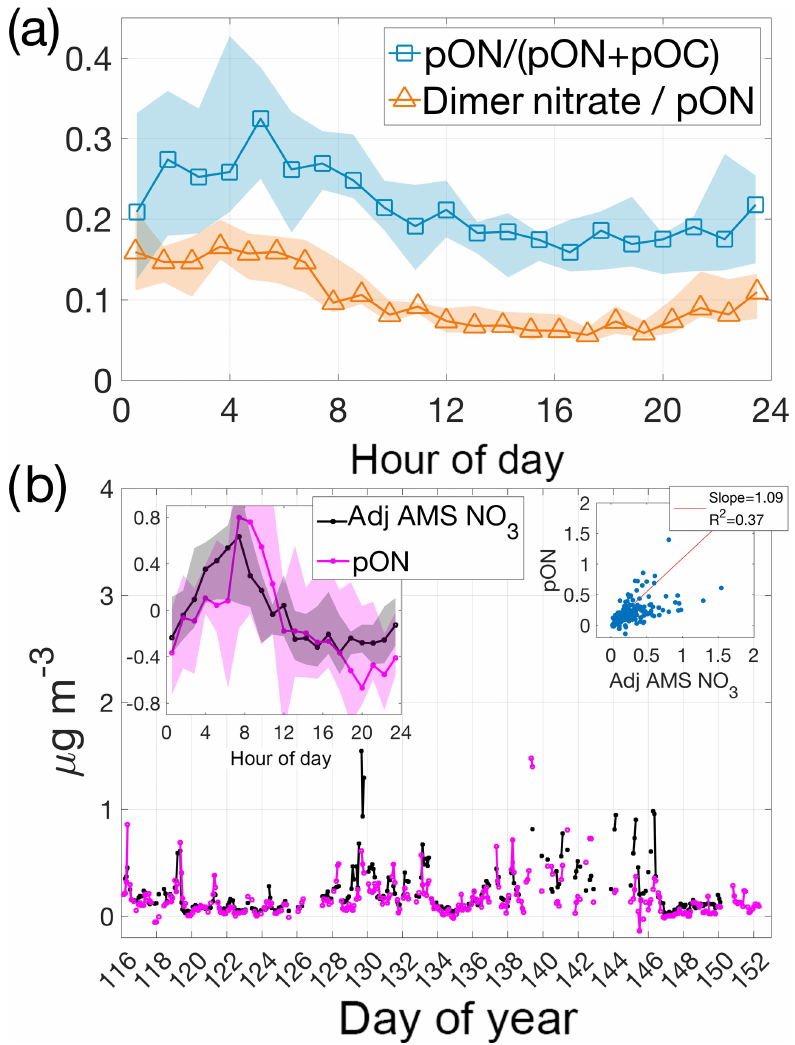
Figure 8. (a) Mass fraction of (blue) particulate organic nitrates to the total organic aerosol mass loading, both measured by the FIGAERO- CIMS and mass fraction of (orange) dimer nitrates to the total organic nitrates, both measured by the FIGAERO-CIMS, as a function of hour of day. (b) Mass concentrations of (magenta) particulate organic nitrates measured by FIGAERO-CIMS and (black) total particle NO 3 measured by HRToF-AMS but adjusted assuming all of the particle NO 3 is composed of organic nitrates with an average molecular weight of 265gmol − 1 (i.e., assuming no contribution from inorganic nitrates such that adjusted AMS NO 3 = AMS NO 3 × 265 / 62). Insets in (b) show the comparison between pON and adjusted AMS NO 3 , and the deviation from their daily respective means as a function of hour of